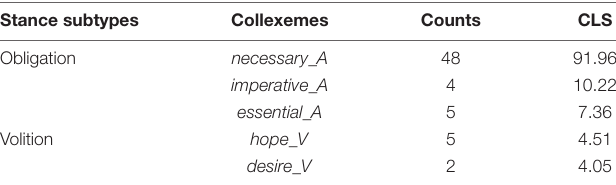
TABLE 3 | Adjectival and verbal collexemes associated with Deontic stance.